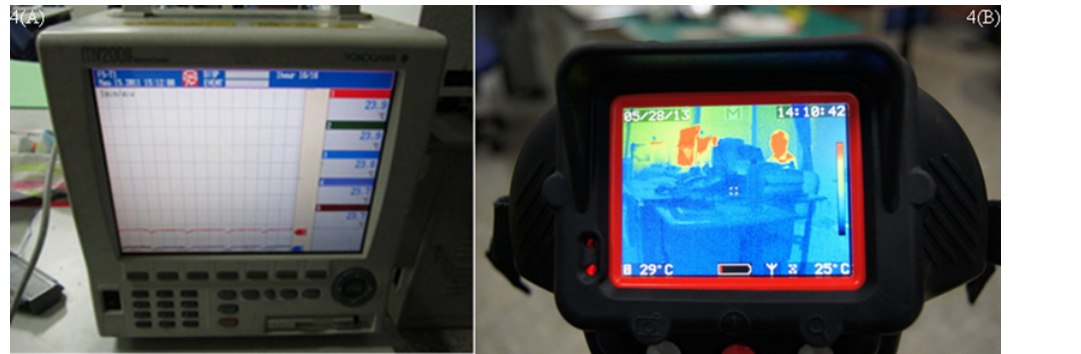
Fig 4. A: Thermocouple measurement device. B: Infrared thermal imager.